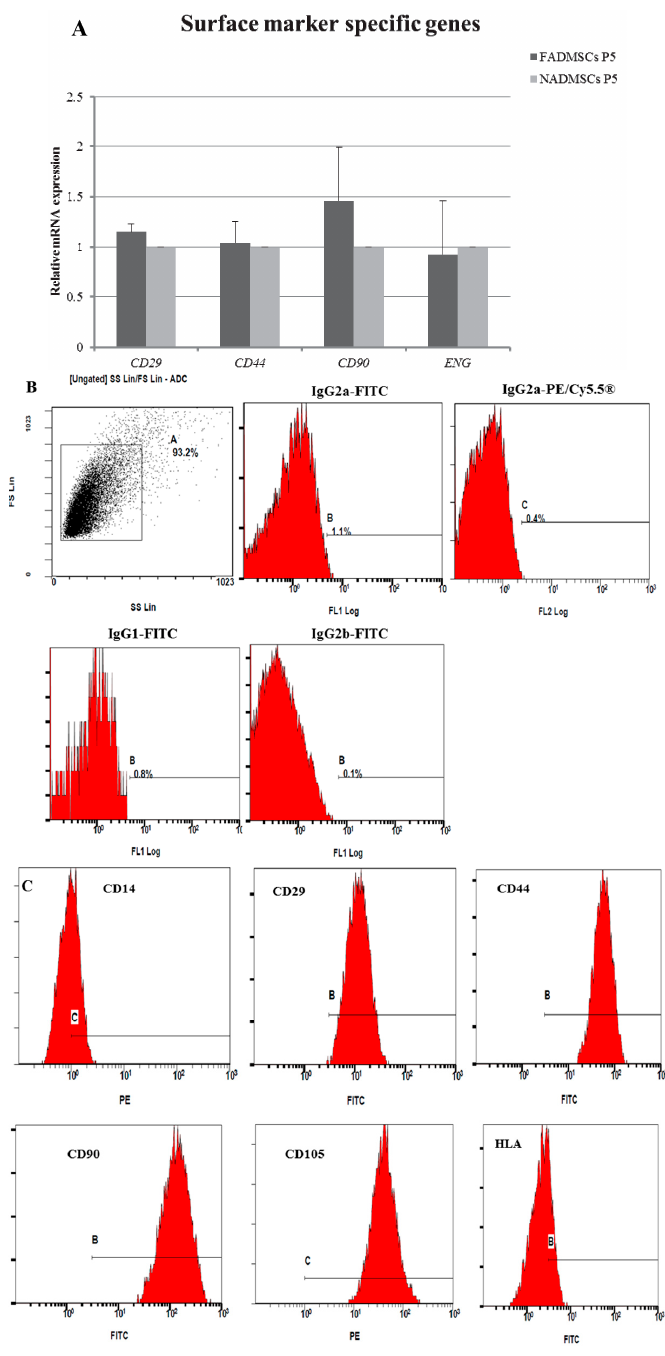
Figure 4. Cont. Figure 4.